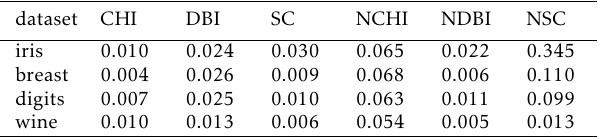
Table 6. Clustering results - Changing Objects in